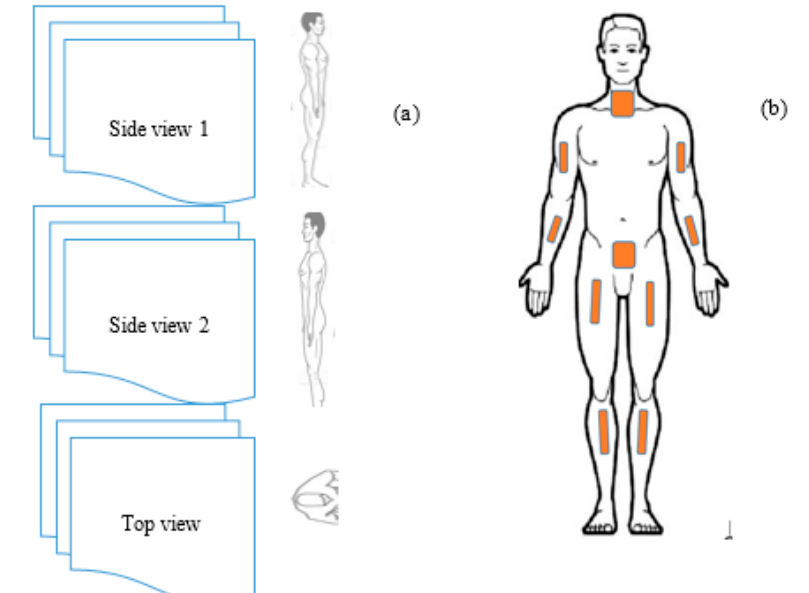
Figure 1. The figure shows a multi-view situation where ( a ) shows how human actions are captured from different perspectives, while ( b ) shows how various sensors are connected on the body of a human being so as to gather enough action data (images from Google